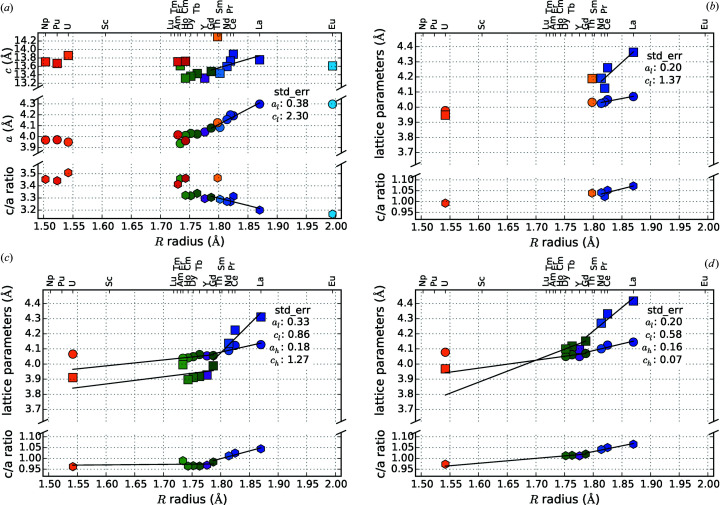
Influence of the radius of the R element on compounds with identical valence electron amount and constant T element. (a) tetragonal RSi2 compounds, (b) hexagonal R
2NiSi3 compounds, (c) hexagonal R
2RhSi3 compounds and (d) hexagonal R
2PtSi3 compounds. The color changes with the atomic number of the R element, according to the color code from the correlation plots. Additionally, the element symbols are given at the top of the diagrams. The markers symbolize lattice parameter a (circle), lattice parameter c (square), and the ratio c/a (hexagon). The standard error are given for the indicated regression lines of the a and the c parameter, separated according light and heavy lanthanoids (l and h, respectively). The color code is adapted from the correlation plots.